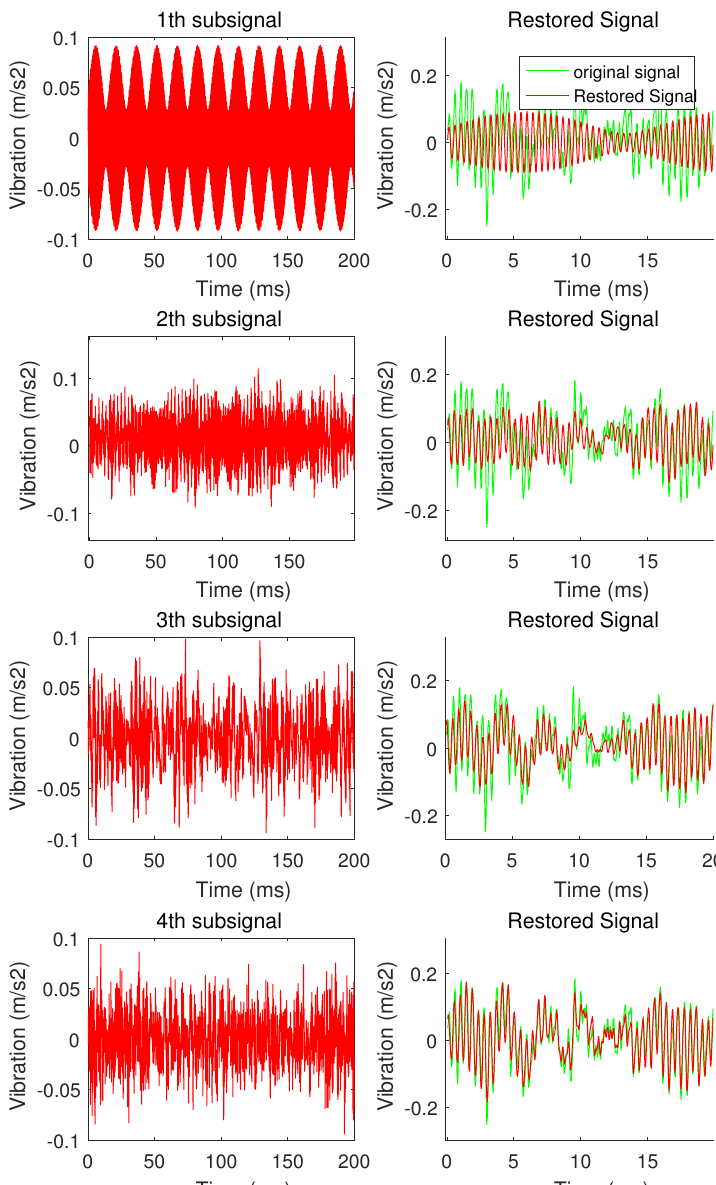
Figure 14. Amplitude spectrum and power